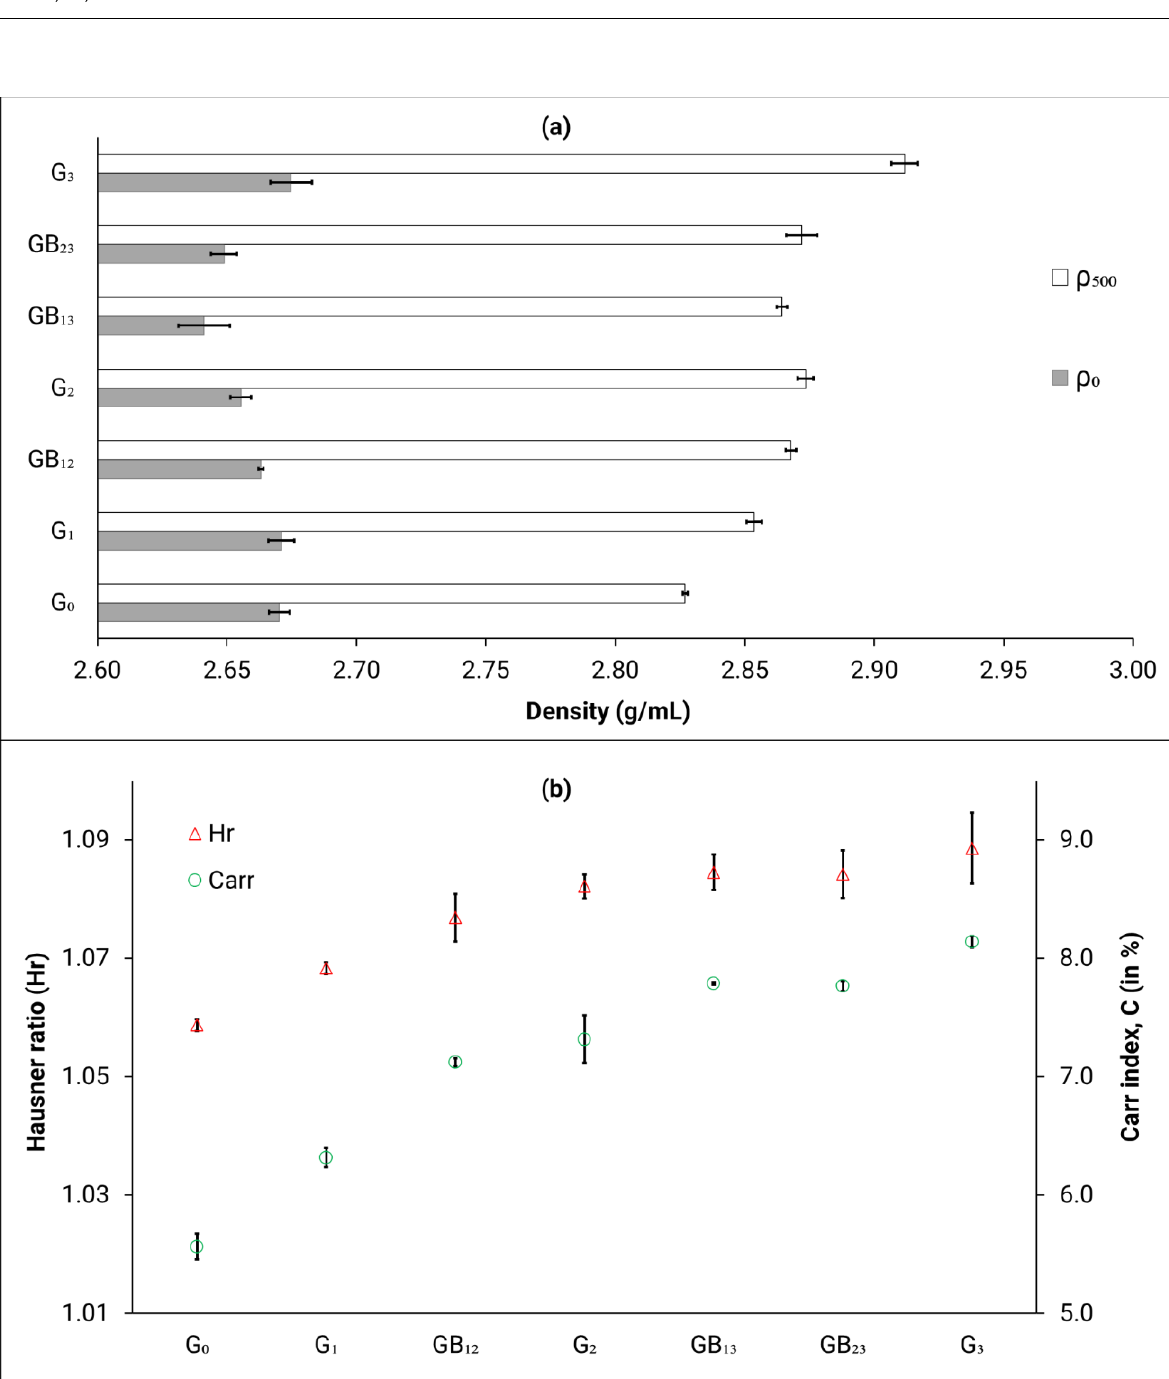
Figure 4. ( a ) ρ 0 and ρ 500 values ( b ) Hr and C values; for all powder types. Error bars represent the standard